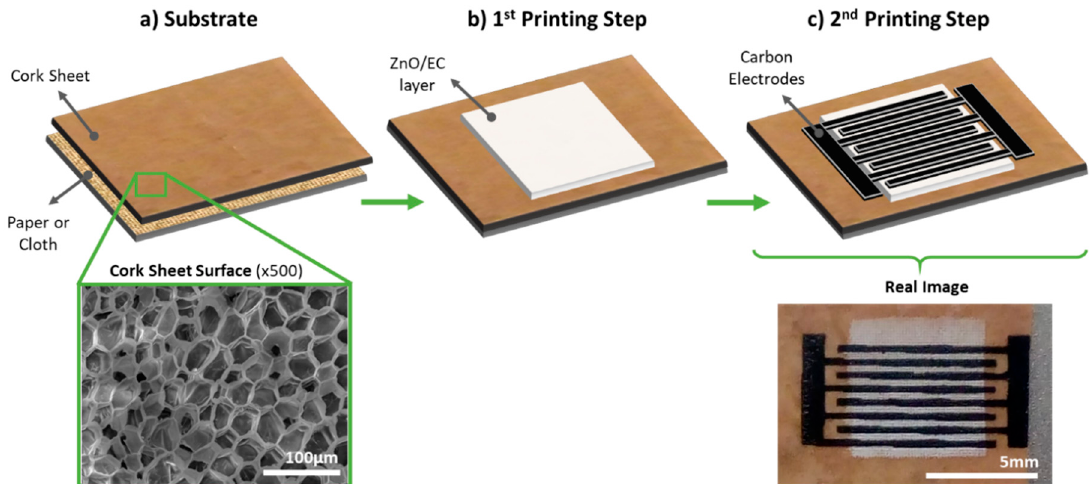
Figure 1. UV photosensor printing process scheme: ( a ) cork substrate glued to paper or fabric; ( b ) ZnO/EC (ethylcellulose) active layer printing step; ( c ) carbon interdigital electrode printing step. A